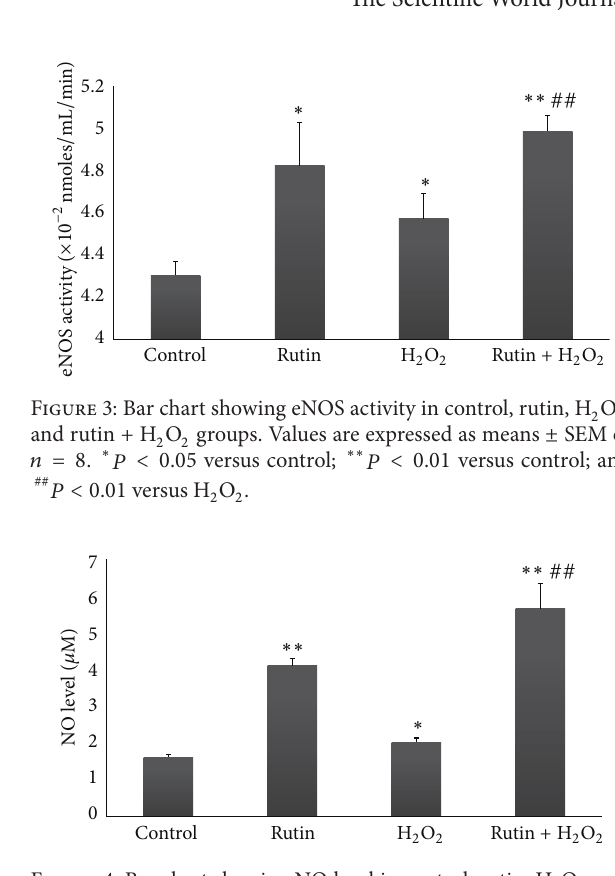
Figure 4: Bar chart showing NO level in control, rutin, H 2 O 2 , and rutin + H 2 O 2 groups. Values are expressed as means ± SEM of 𝑛 = 8 . ∗ 𝑃 < 0.05 versus control; ∗∗ 𝑃 < 0.01 versus control; and ## 𝑃 < 0.01 versus H 2 O 2